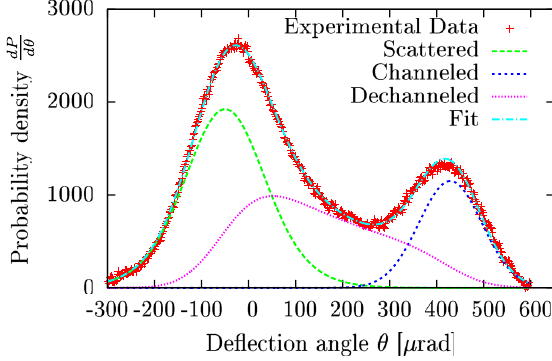
FIG. 11. A fit to the 3.5 GeV experimental data in the channeling